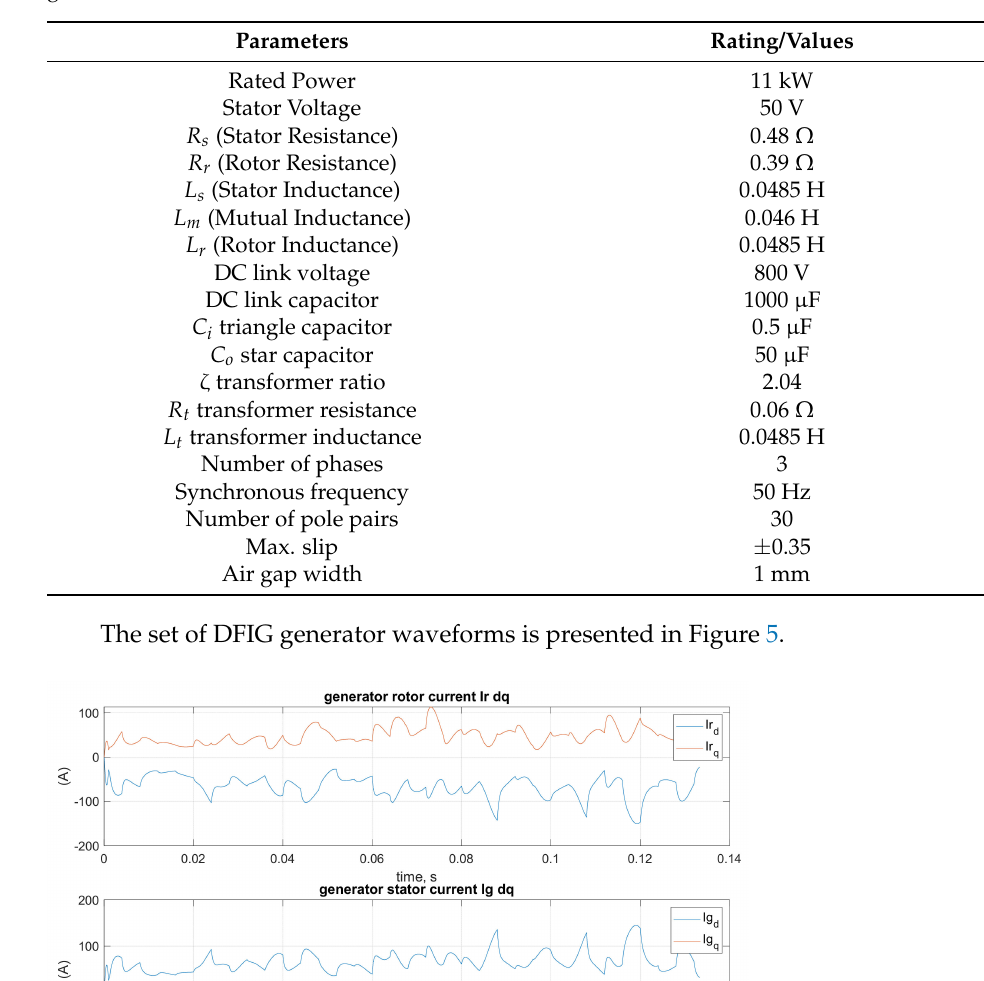
Table 1. Specification and parameters of the DFIG generator and of the system supplying the islanded grid.